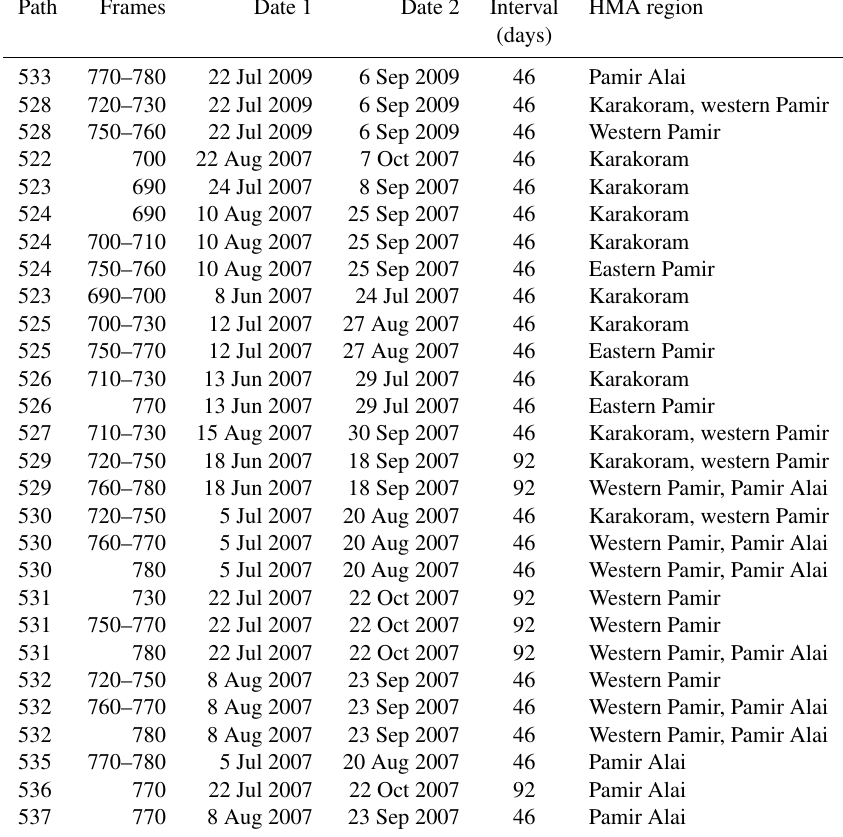
Table 2. List of ALOS-1 PALSAR-1 scenes used to generate the coherence images.